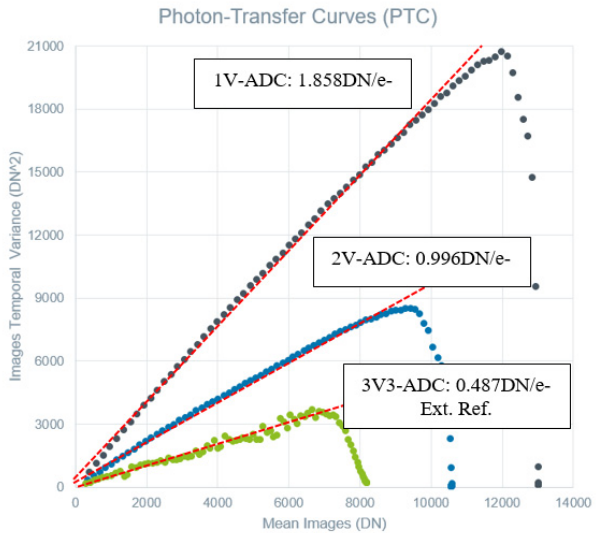
Figure 8. Combined photon transfer curve (PTC) data as a function of the image’s mean